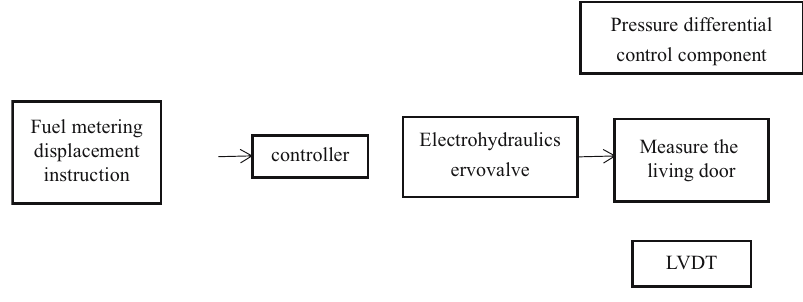
Figure 2: FMU control